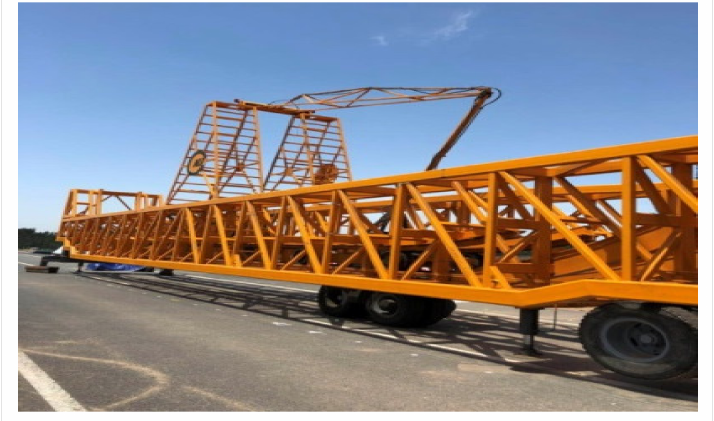
Figure 2. Accelerated loading system.